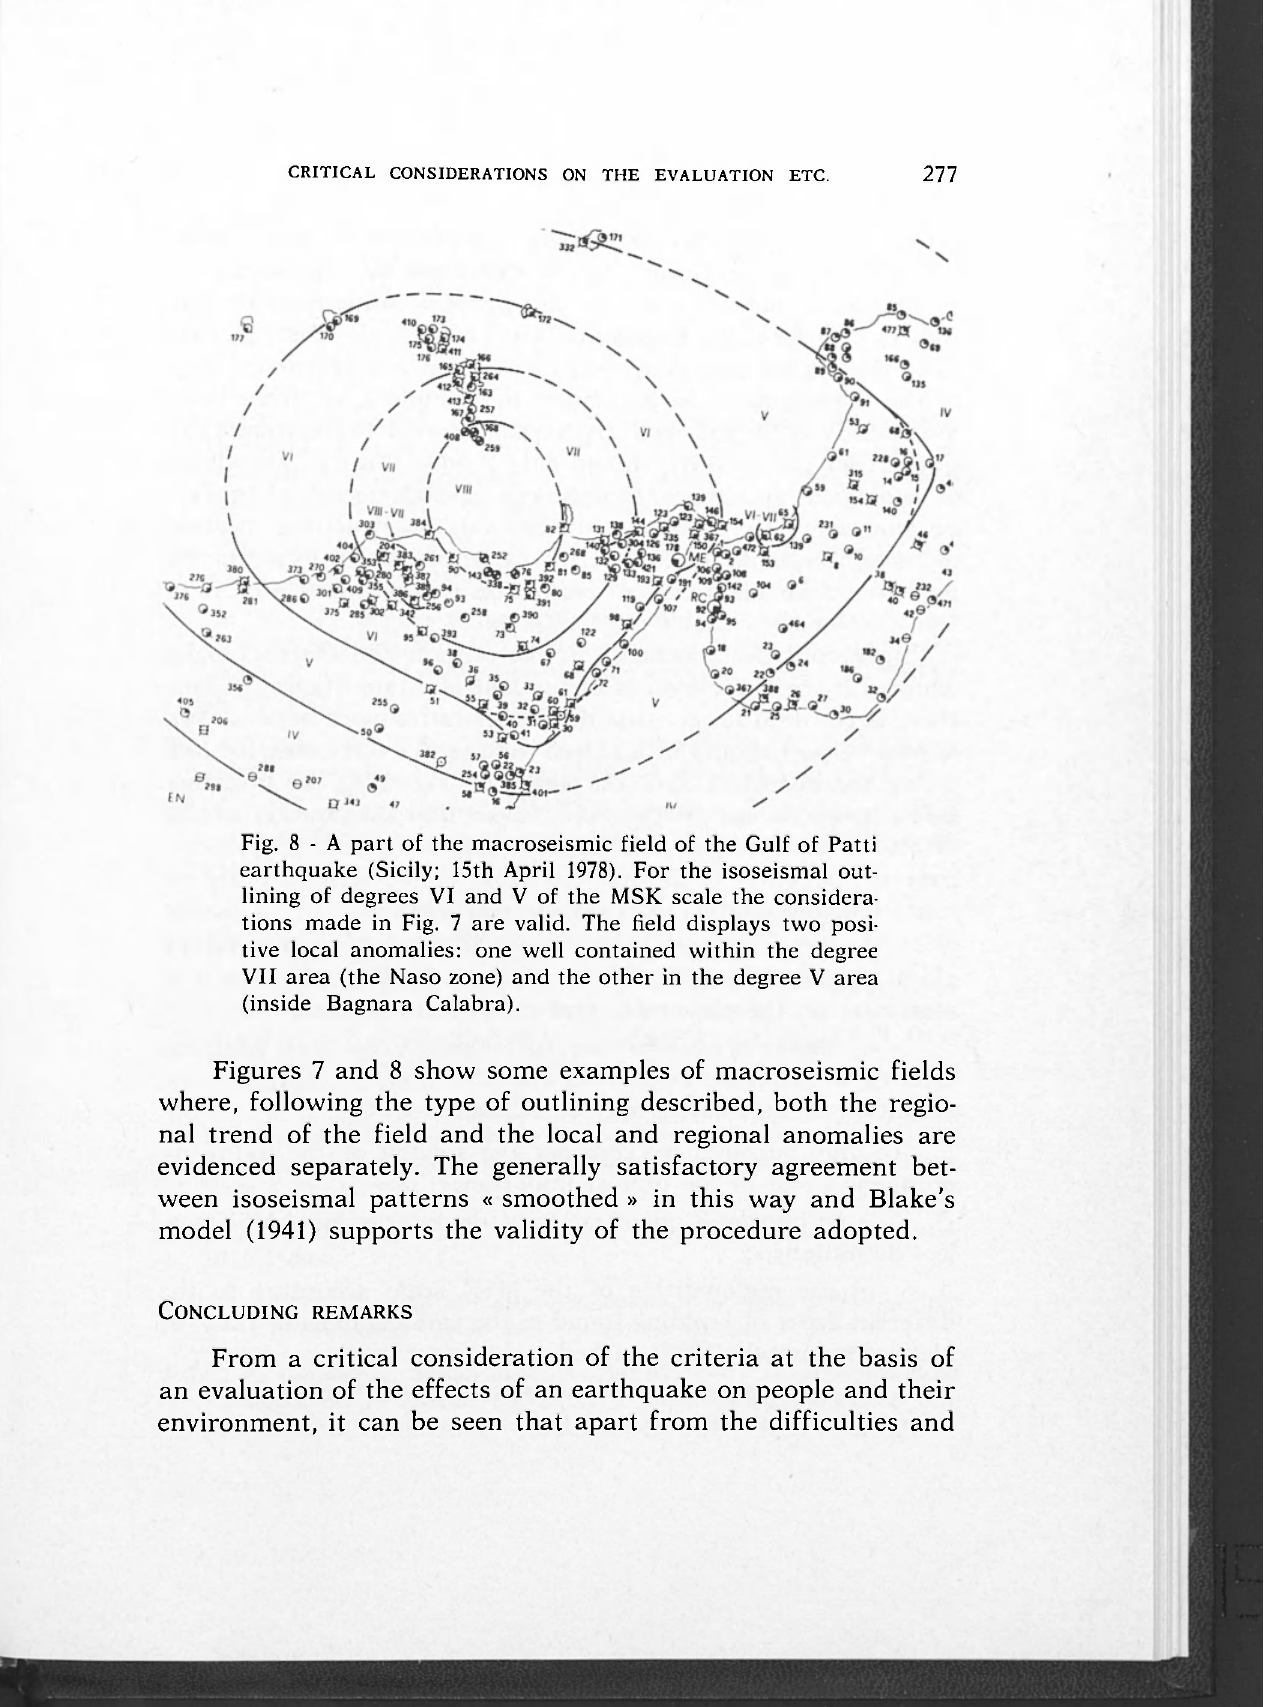
Fig. 8 - A part of the macroseismic field of the Gulf of Patti earthquake (Sicily; 15th April 1978). For the isoseismal out- lining of degrees VI and V of the MSK scale the considera- tions made in Fig. 7 are valid. The field displays two posi- tive local anomalies: one well contained within the degree VII area (the Naso zone) and the other in the degree V area (inside Bagnara